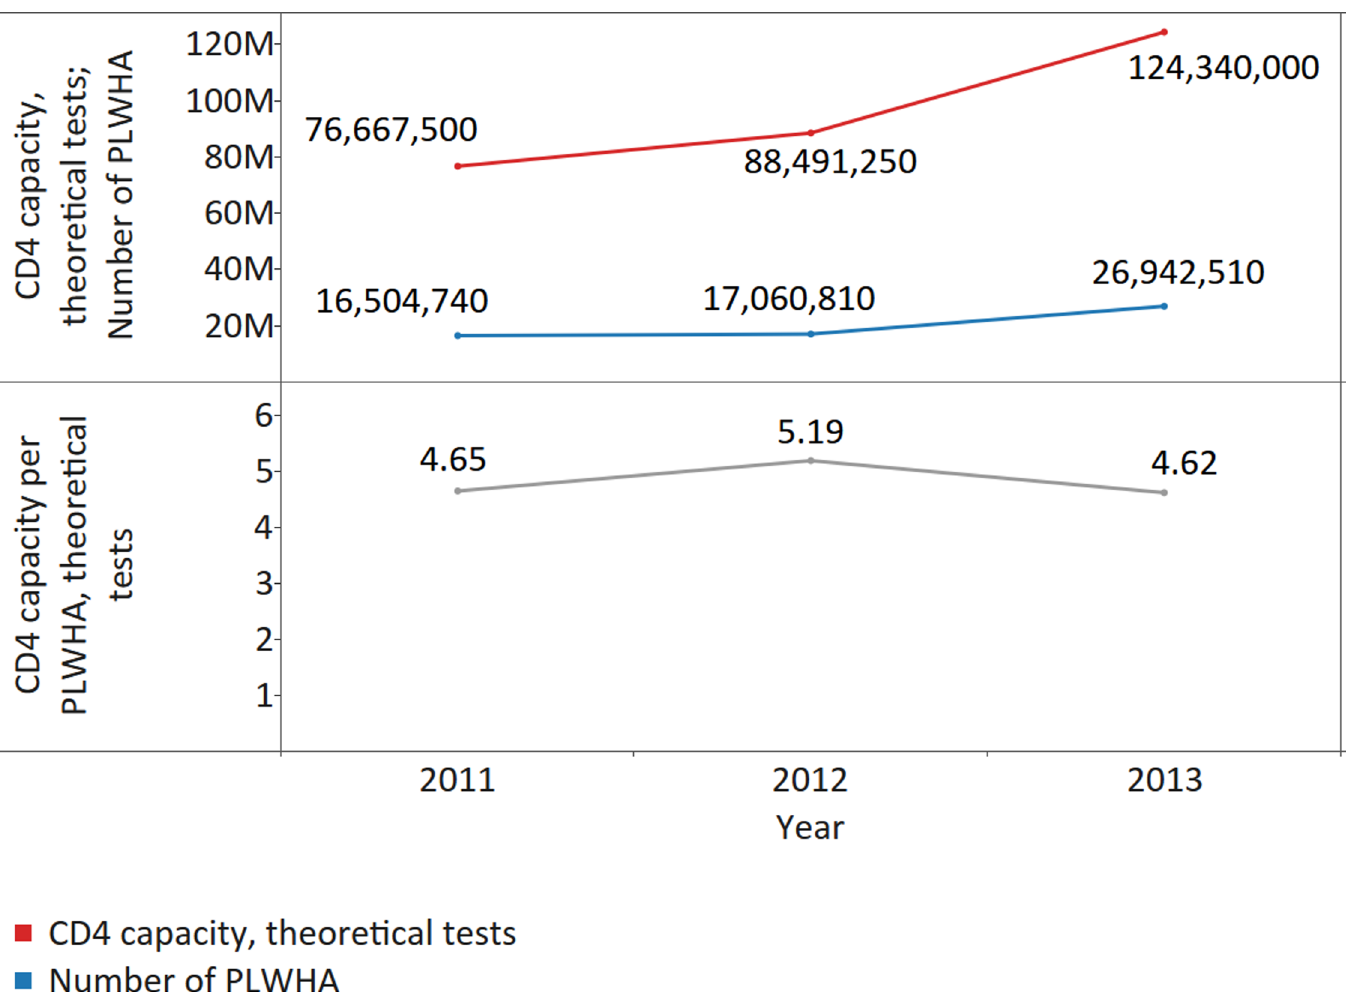
Fig 3. CD4 capacity per people living with HIV/AIDS (PLWHA), for all reporting countries. The upper panel shows the number of PLWHA and the theoretical CD4 capacity for the 66, 71, and 68 countries with data available for number of instruments and number of PLWHA in 2011, 2012, and 2013, respectively. The lower panel shows the CD4 capacity per